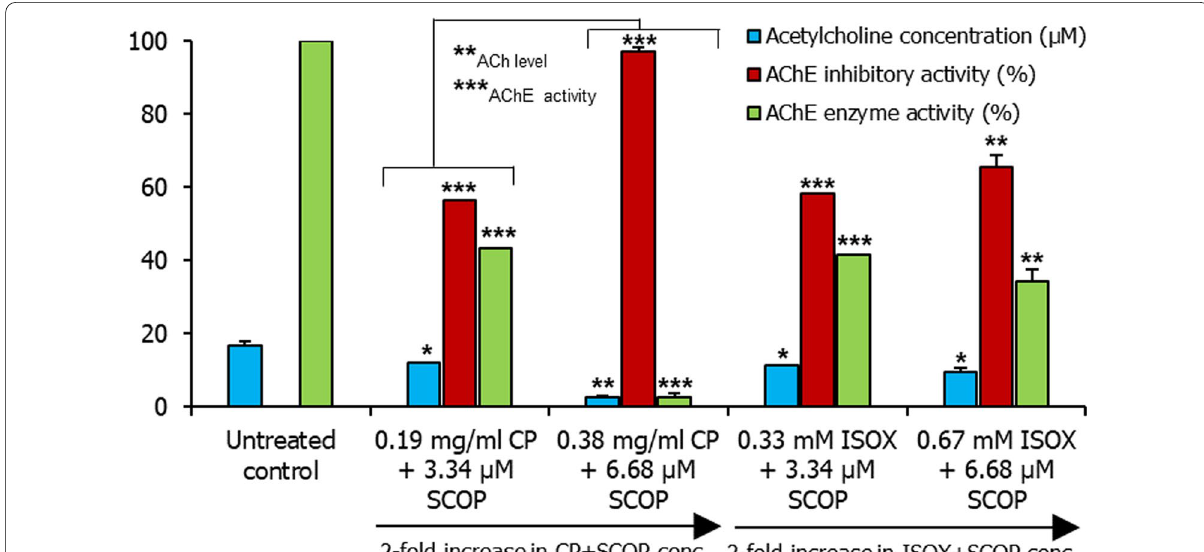
Fig. 8 Concentration-dependent effect of CP SCOP and ISOX SCOP on acetylcholinesterase activity and acetylcholine levels. Acetylcholine + + (ACh) levels (blue bars), acetylcholinesterase (AChE) inhibitory activity (red bars), and acetylcholinesterase enzyme activity (green bars) in 168 hpf larvae unexposed to any test compound (i.e. ‘untreated’) and treated with the combinations of scopolamine (SCOP) with Convolvulus pluricaulis (CP) and isoxazole (ISOX), i.e. CP SCOP and ISOX SCOP, in varying concentrations have been shown. Two concentrations were tested for each + + of these combinations. For CP SCOP, these were 0.19 mg/ml of CP 3.34 μM of SCOP and 0.38 mg/mL of CP 6.68 μM of SCOP. For ISOX SCOP, + + + + these were 0.52 mM of ISOX 3.34 μM of SCOP and 1.04 mM of ISOX 6.68 μM of SCOP. Both the ACh level (µM) and AChE activity (%) have been + + expressed as mean standard deviation. Three independent experiments were conducted to determine ACh level and AChE activity, and in each of ± these experiments, three sets of 15–25 embryos were treated with the said concentrations. The larvae were treated with the AChE inhibitor (i.e. ISOX or CP) 1 h before treatment with SCOP. *, **, and *** indicate p-value < 0.5, < 0.01 and < 0.001 of two-tailed unpaired t-test for untreated versus test groups respectively